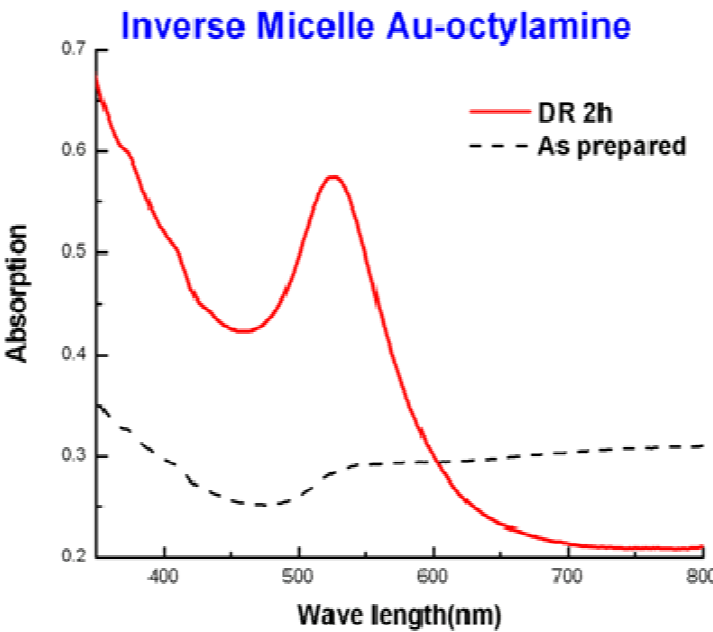
Figure 7. UV-Visible spectrum of Au-octylamine colloid by inverse micelle method before and after digestive ripening 2 h in